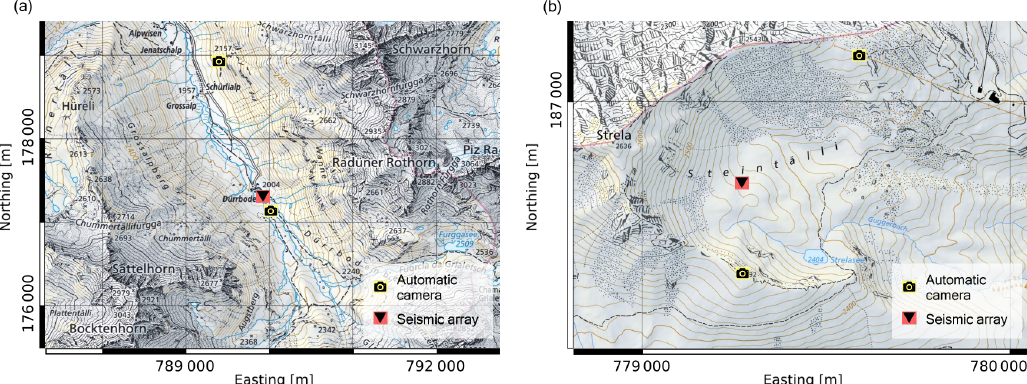
Figure 2. (a) Detailed map of the Dischma field site showing the position of the seismic array and the automatic cameras. (b) Same as (a) , but for the Wannengrat field site. Reproduced with permission from Swisstopo